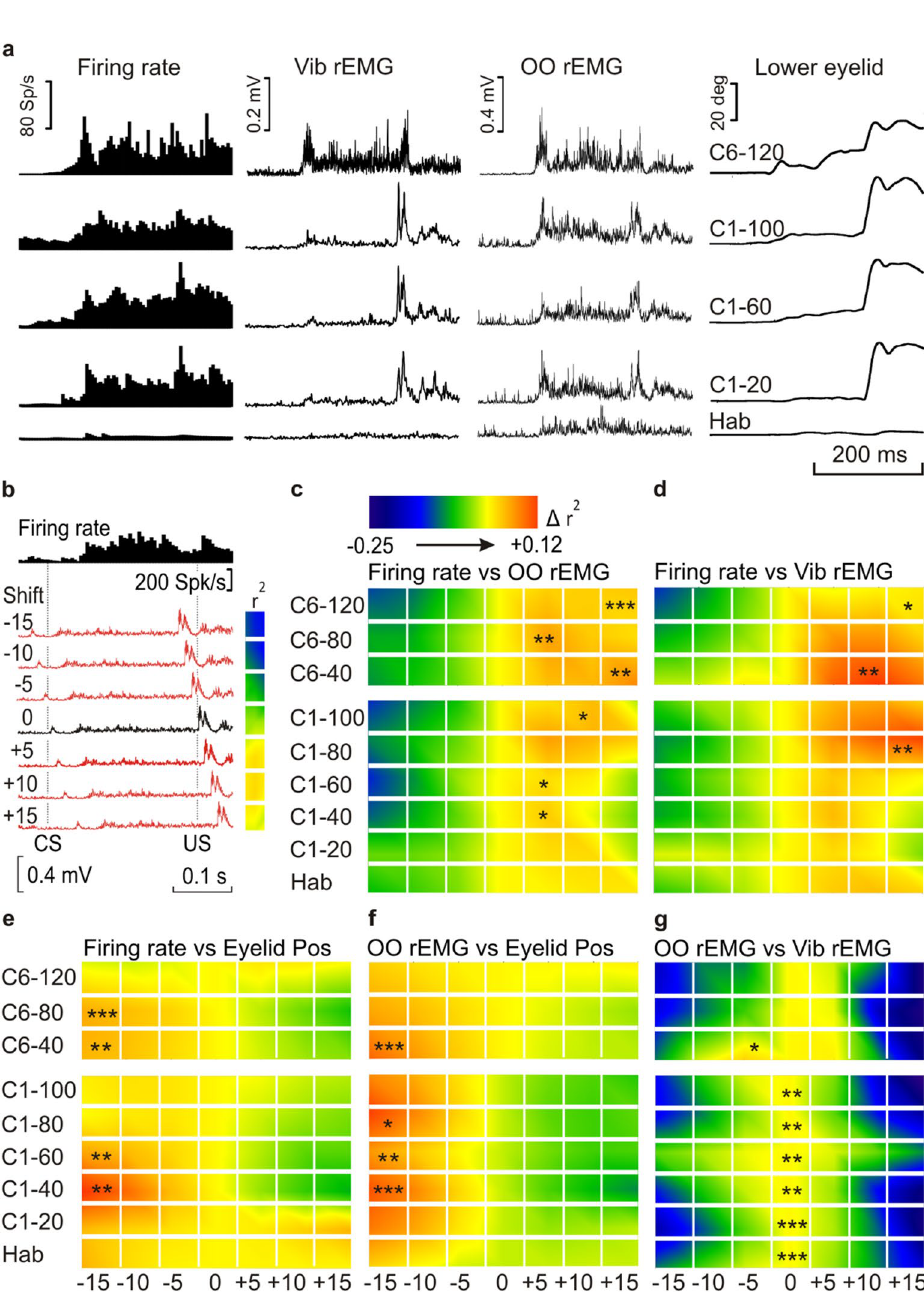
Figure 5. Timing correlation between MC neuron firing rate, OO rEMG, Vib rEMG, and lower-eyelid position, during eyeblink and vibrissae conditioning with a delay paradigm. ( a ) MC firing rate, Vib rEMG, OO rEMG, and lower-eyelid position corresponding to the average of 20 habituation (Hab), three groups of 20 trials from the first conditioning session (C1–20, C1–60, and C1–100), and the average of the last 40 trials from the sixth conditioning session (C6–120). ( b ) An example of the method used to compute the coefficient of determination (r 2 ) between the firing rate of MC neurons and the OO rEMG. r 2 values obtained from the comparison between a neuron firing rate and the corresponding OO rEMG, when the OO rEMG was shifted from − 15 to + 15 ms in 5-ms steps (red traces) from the actual timing (0 ms, black trace). For each comparison, the collected r 2 value is represented by a colored square to the right of each OO rEMG recording. The calibration for color gradient values is shown at the top in ( c ). Higher r 2 values corresponding to negative-shifted recordings indicate a delay with respect to the correlated (actual) recording, whereas higher r 2 values corresponding to positive-shifted recordings indicate an advance with respect to the correlated one (as in the example). ( c – g ) Colorimetric representation of the timing correlation between MC neuron firing rate vs. OO rEMG ( c ), MC neuron firing rate vs. Vib rEMG ( d ), MC neuron firing rate vs. eyelid position ( e ), OO rEMG vs. eyelid position ( f ) and OO rEMG vs. Vib rEMG ( g ), calculated as shown in ( b ). See color code of normalized r 2 values at the top of ( c ). Illustrated data correspond to the average of n = 7 animals for Hab and C1 and n = 6 for C6. Asterisks represent significant differences between any of the seven averaged normalized r 2 values, corresponding to the − 15, − 10, − 5, 0, + 5, + 10, and + 15 ms shifted recordings compared, for each set of habituation and conditioning averaged group of trials, and are allocated over the higher r 2 values, * P < 0.05; ** P < 0.01; *** P <